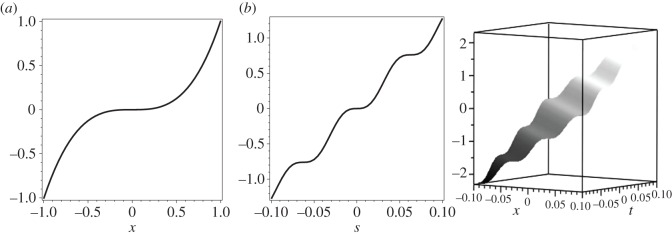
Profileof dP(s)=(1/caλ2)(s−sinh(αs)/α), s=λt+βx, for (a) λ=0, β=1 with α=0, (b) two- and three-dimensional profiles for λ=1, β=1, with α=100i.